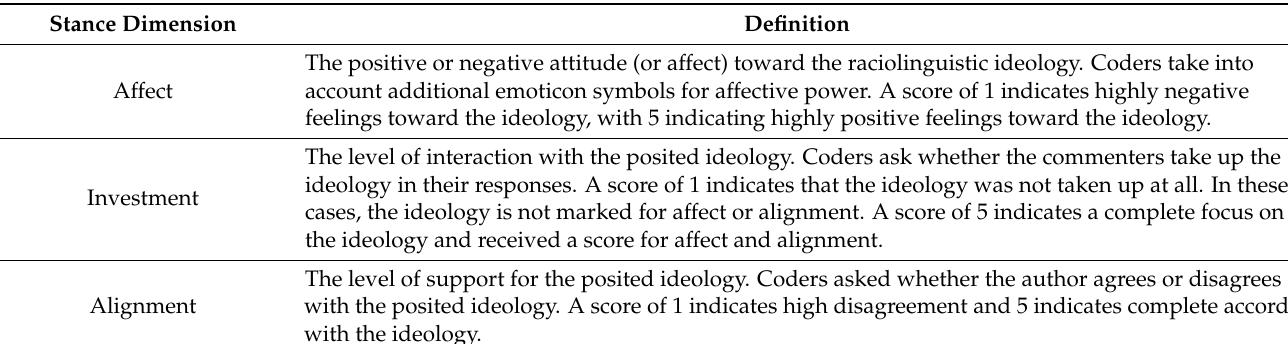
Table 2. Stance dimension